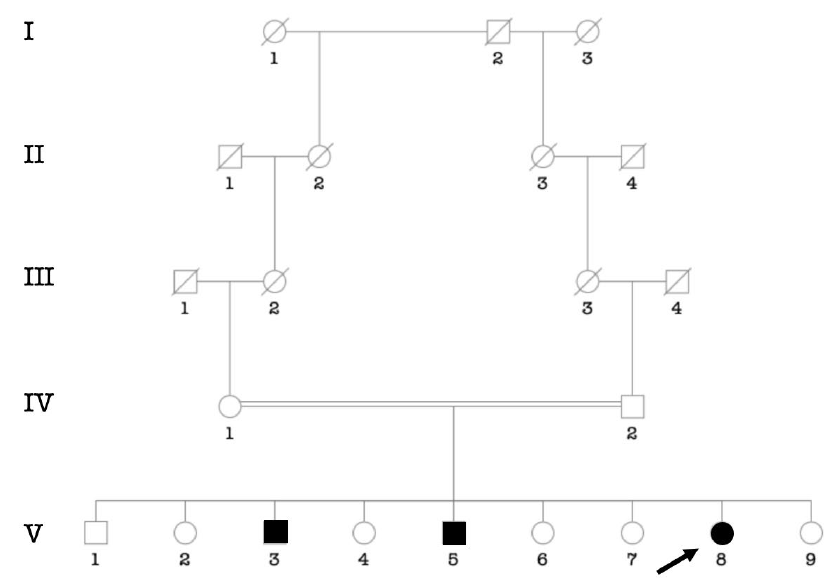
Figure 7. Pedigree showing three affected individuals segregating Usher syndrome. The arrow indicates the proband.